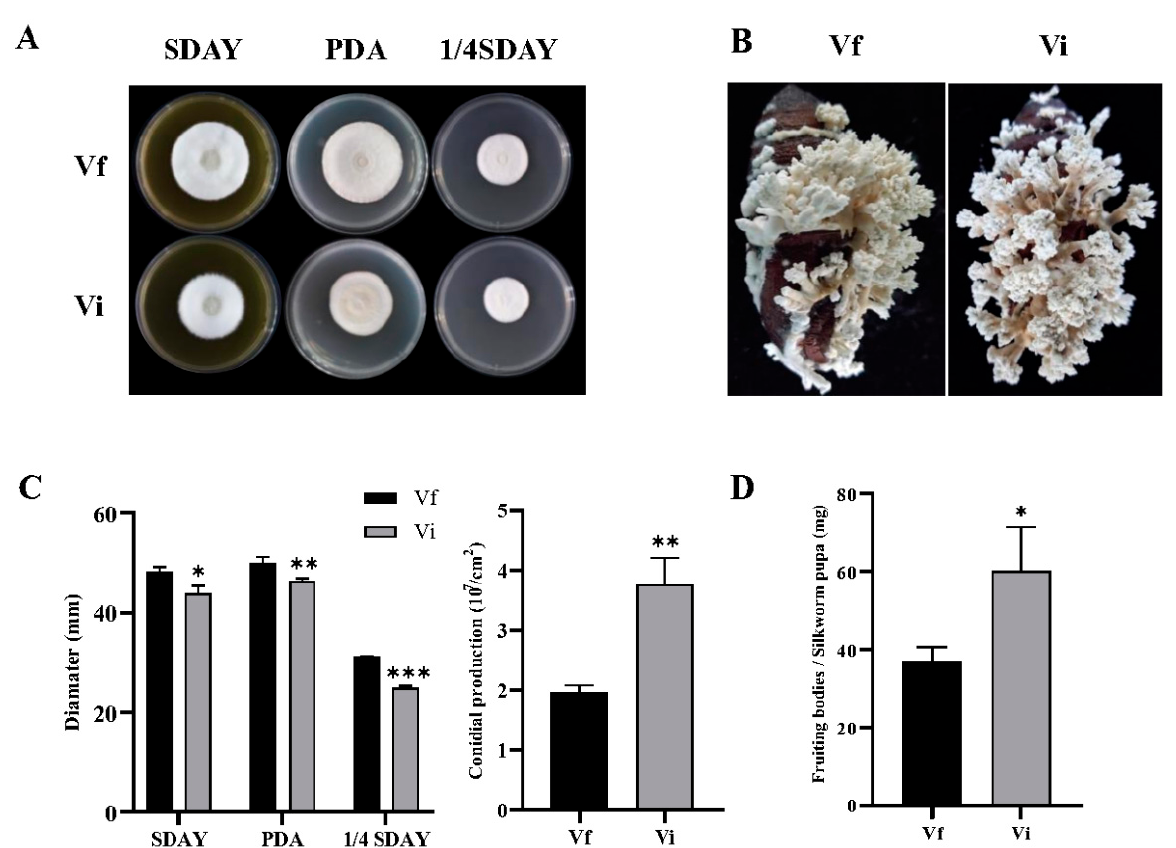
Figure 5. Fungal development of Vf and Vi strains. ( A ) Colony morphology of strains Vf and Vi growing on different media. ( B ) The growth of asexual fruiting on Chinese tussah silkworm pupae. ( C ) Left: diameters of strains grown for 10 days on PDA, SDAY, and 1/4 SDAY, respectively; Right: sporulation of the strains after 10 days of growth. ( D ) The production of the fruiting bodies of 1 g of pupae produced by Vi and Vf strains. * p < 0.05, ** p < 0.01, *** p < 0.001.